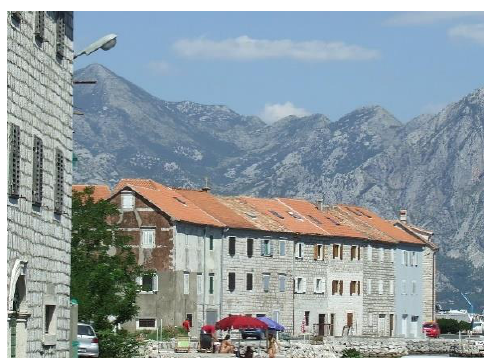
Figure 11. A row of houses in Prčanj and Muo.